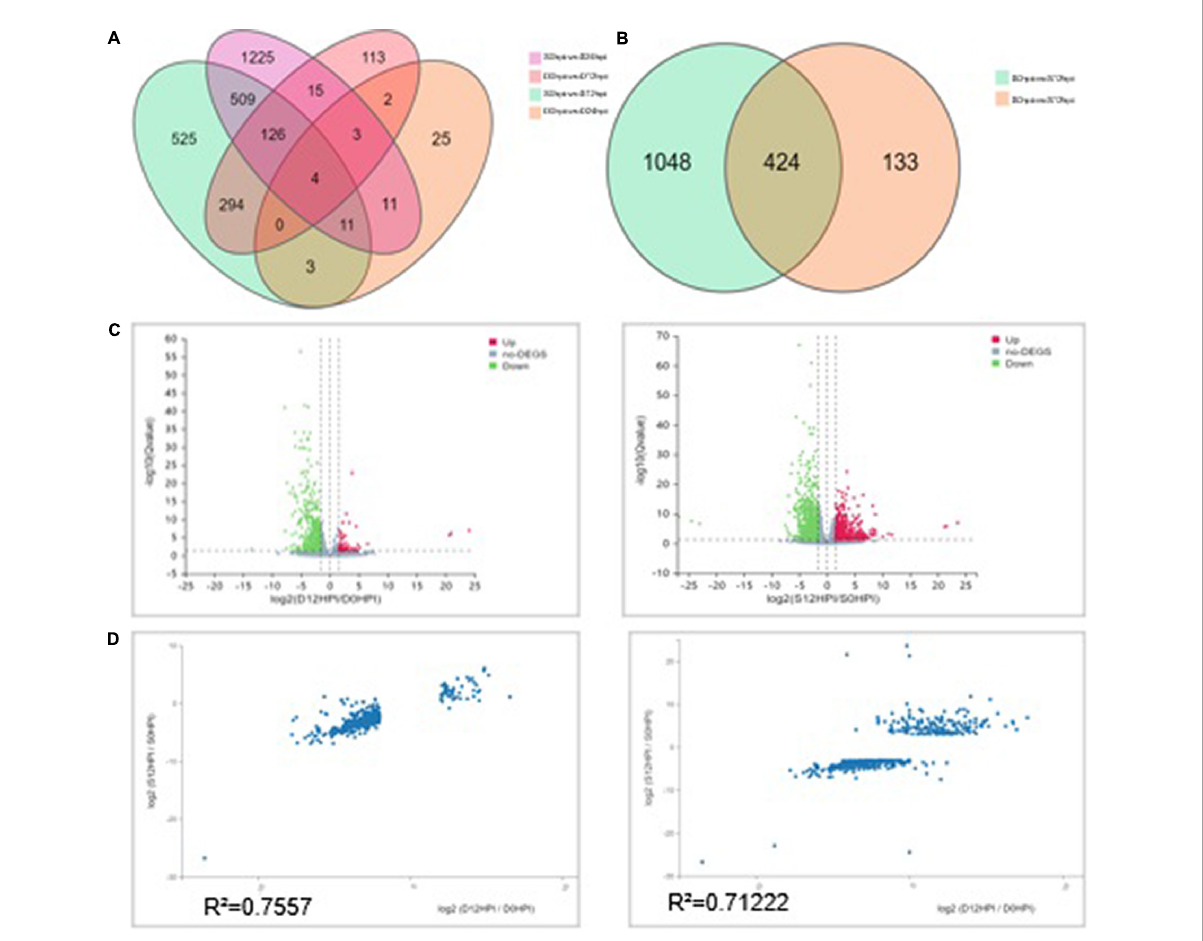
FIGURE3 Differentially expressed genes (DEGs) analysis among groups at different time points. (A) Venn diagram showing the relationship between the differentially expressed genes at 12 and 24 hpi, respectively. The values in each circle represent the number of genes. The cut-off value of log2 fold changes for up-regulated and down-regulated gene/protein was ± 1.58. (B) The Venn diagram distribution of DEGs in groups S and D at 12hpi. (C) Volcano plot of DEGs signals in groups S (left) and D (right). The scatter in the figure represents each gene; green genes are down-regulated, red genes are up-regulated, and gray genes are not differentially expressed. The vertical axis indicates the P -value ( − log 10 value), | log2FC| ≥ 1.58 were applied for the cut-off value. (D) Correlation between the DEGs (| log2FC| ≥ 1.58) of groups S (left) and D (right) at 12hpi. The value represents 557 DEGs in group D (Left) and 1,472 in group S (Right). The regression line and Pearson’s correlation coefficient are